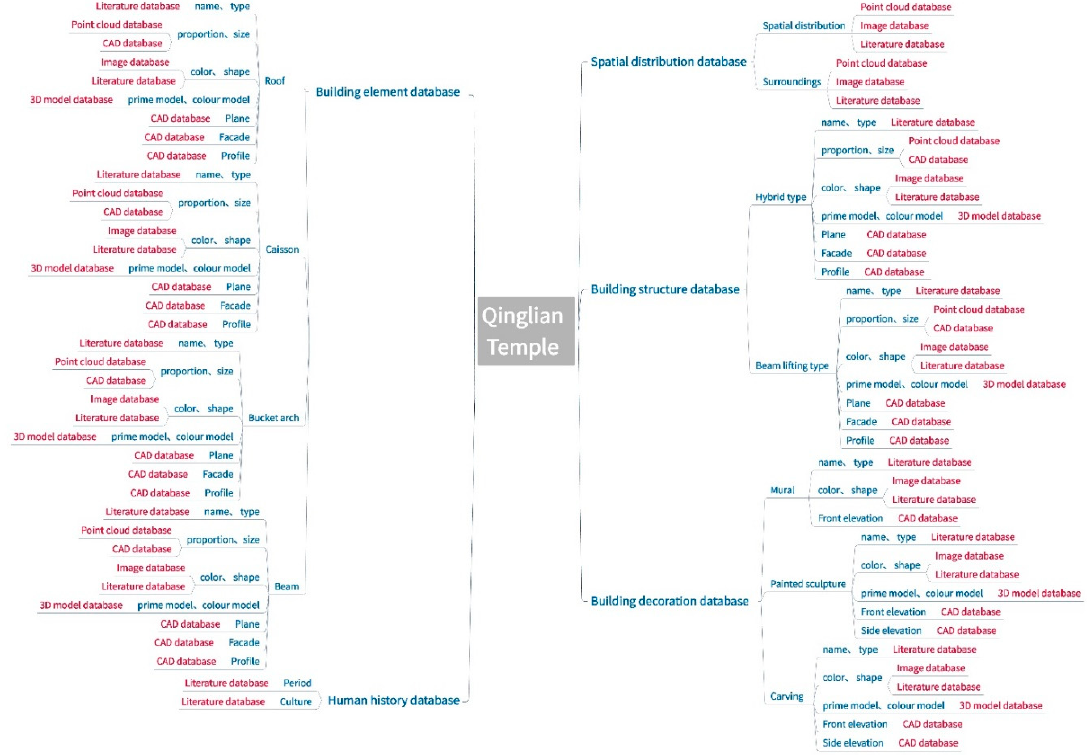
Figure 12. Mind map of Qinglian Temple.